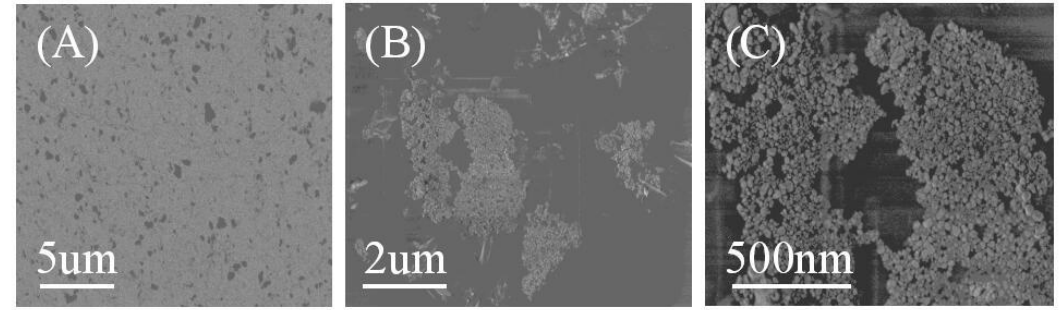
Figure 2. SEM images of bare GDE ( A ) and GDE after electrodeposition of Al(III) ( B ) and enlarge image of deposits ( C ). Films were electroplated at a potential of − 1.80 V for 120 s from the extractant of 10 µg L − 1 Al(III).